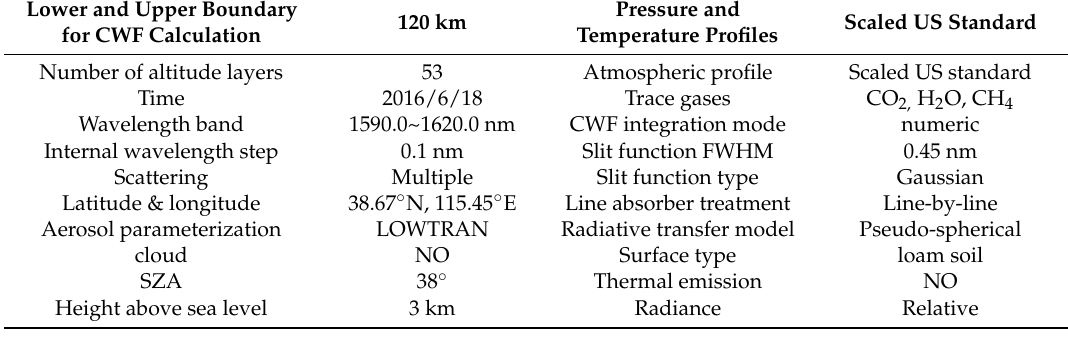
Table 1 The input parameters for SCIATRAN.